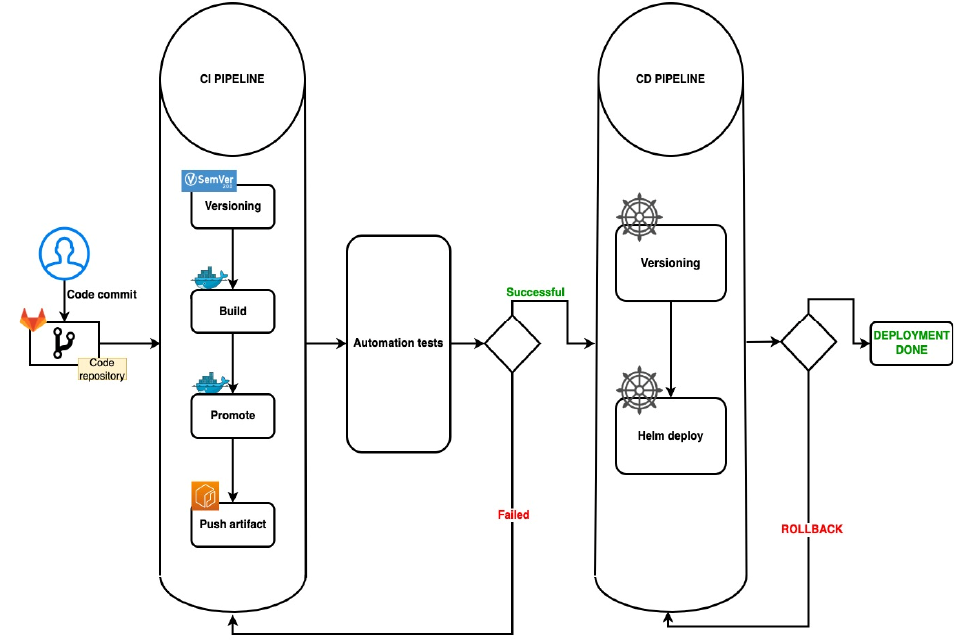
Figure 10. An overall proposed solution flowchart diagram.